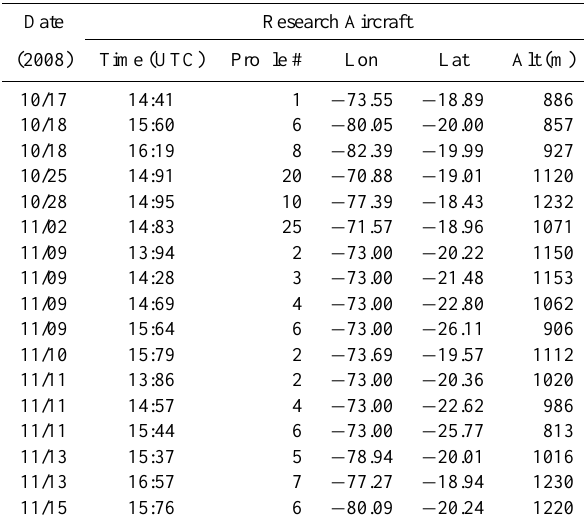
Table 2. Summary of the 17 profiles used in this study. Aircraft time is the mean time of plane pass through the cloud. The altitude is the mean altitude of plane pass through the